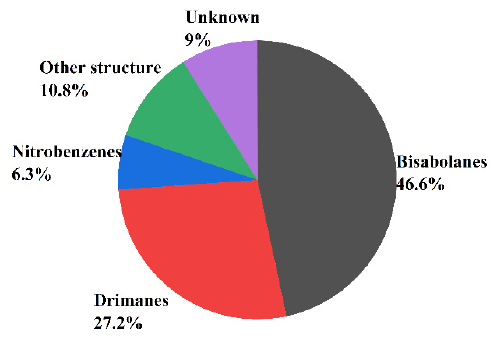
Figure 3. The main types of sesquiterpenoids isolated from Aspergillus sp..